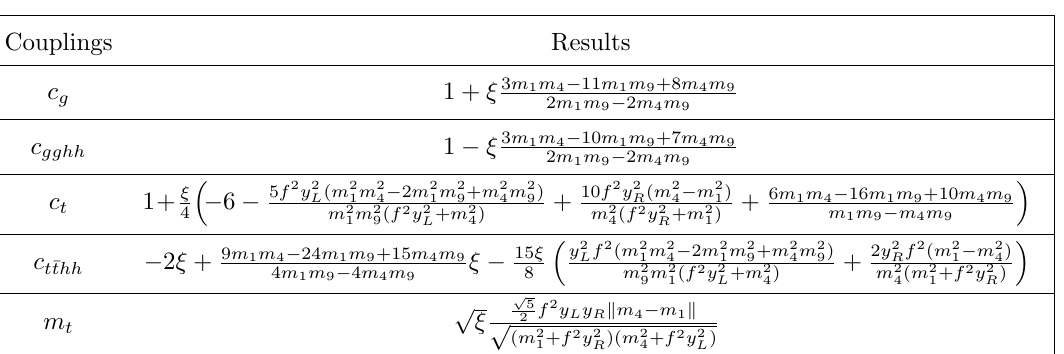
Table 4 . Higgs Couplings and top mass in MCHM of 10 + 10 Representation, which means t L and t R are both embedded in the 10 of SO(5).